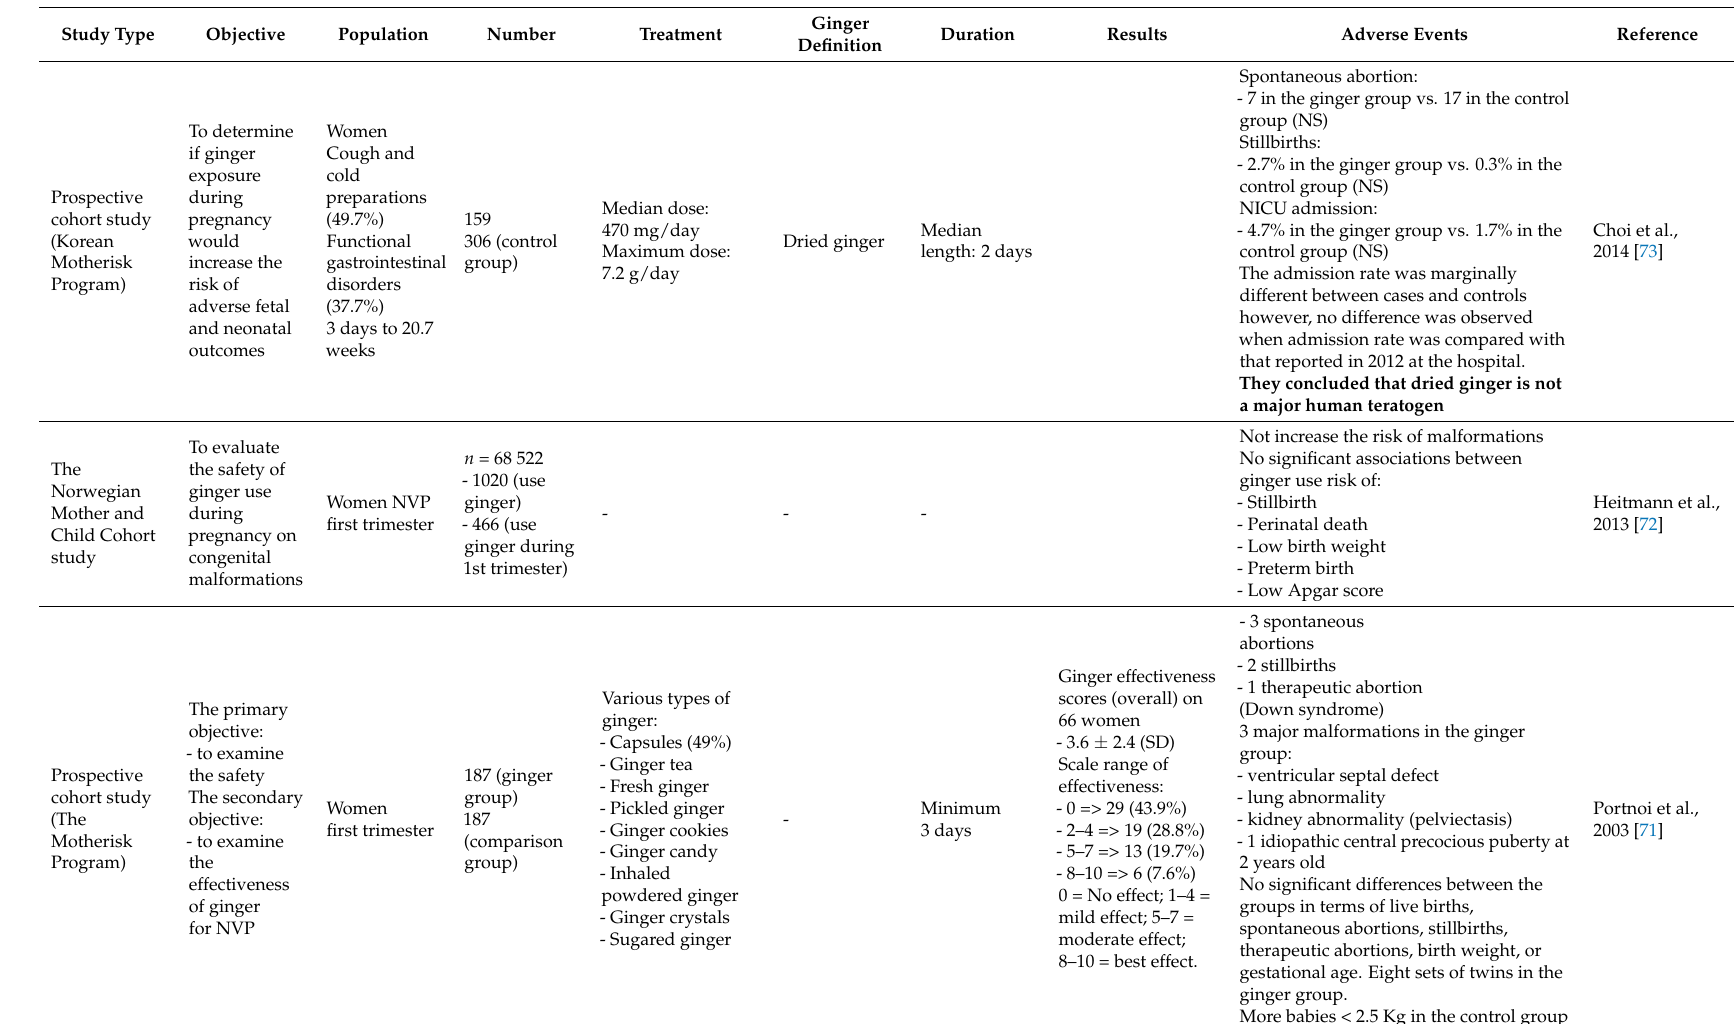
Table 10. Prospective studies investigating the effectiveness and safety of ginger for